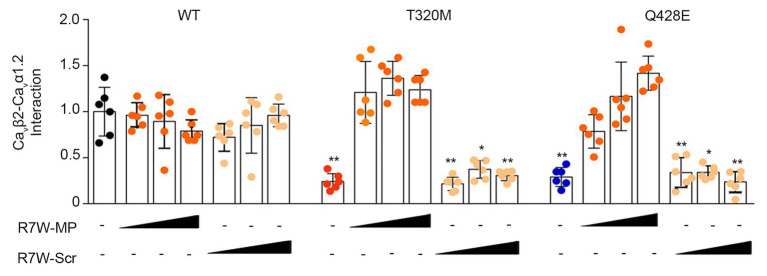
R7W-MP corrects the reduced interaction between mutant Cavα1.2 and Cavβ2. Cavβ2-Cavα1.2 protein affinity as measured in a BRET assay in HEK293 cells transfected with Cavβ2-NanoLuc and Cavα1.2-Halo (WT, T320M, and Q428E mutant) and treated with increasing doses (0.12, 1.3, and 10.2 μM) of R7W-MP and R7W-Scr as indicated (n = 6). *
p < 0.05; **
p < 0.01 (Mann-Whitney test). Black, red, and blue indicate untreated conditions.